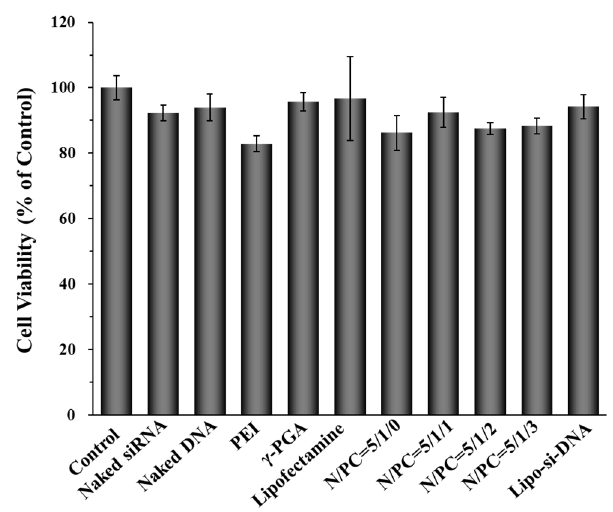
Figure 8. Cell cytotoxicity of raw materials and dual-delivery nanoparticles (DDNPs and γ -DDNPs) composed of different N/P/C ratios after 48 h treatment in Hep 3B cells. The control group means the group of cells without any treatment. Lipo-si-DNA group means the GFP-siRNA and pDsRed DNA transfection by Lipofectamine 2000.